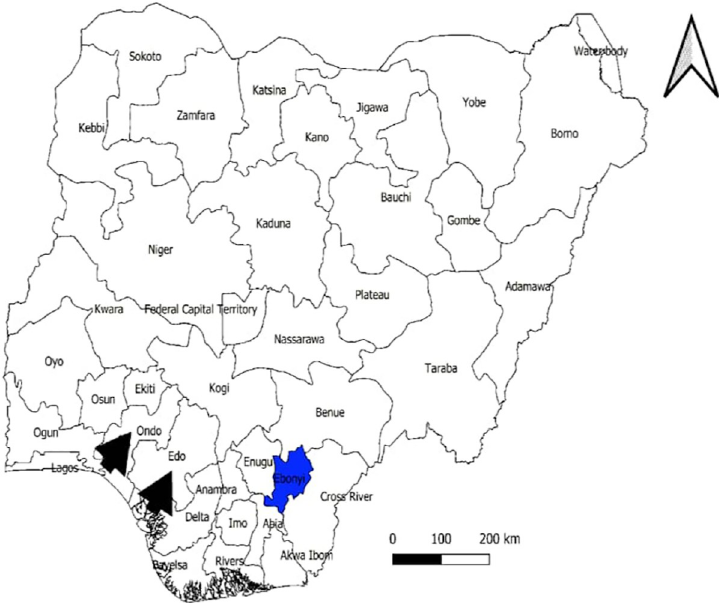
Fig 1. Map of Nigeria Highlighting Ebonyi State. With black arrowheads showing other areas mentioned in this study. Developed using ArcGIS